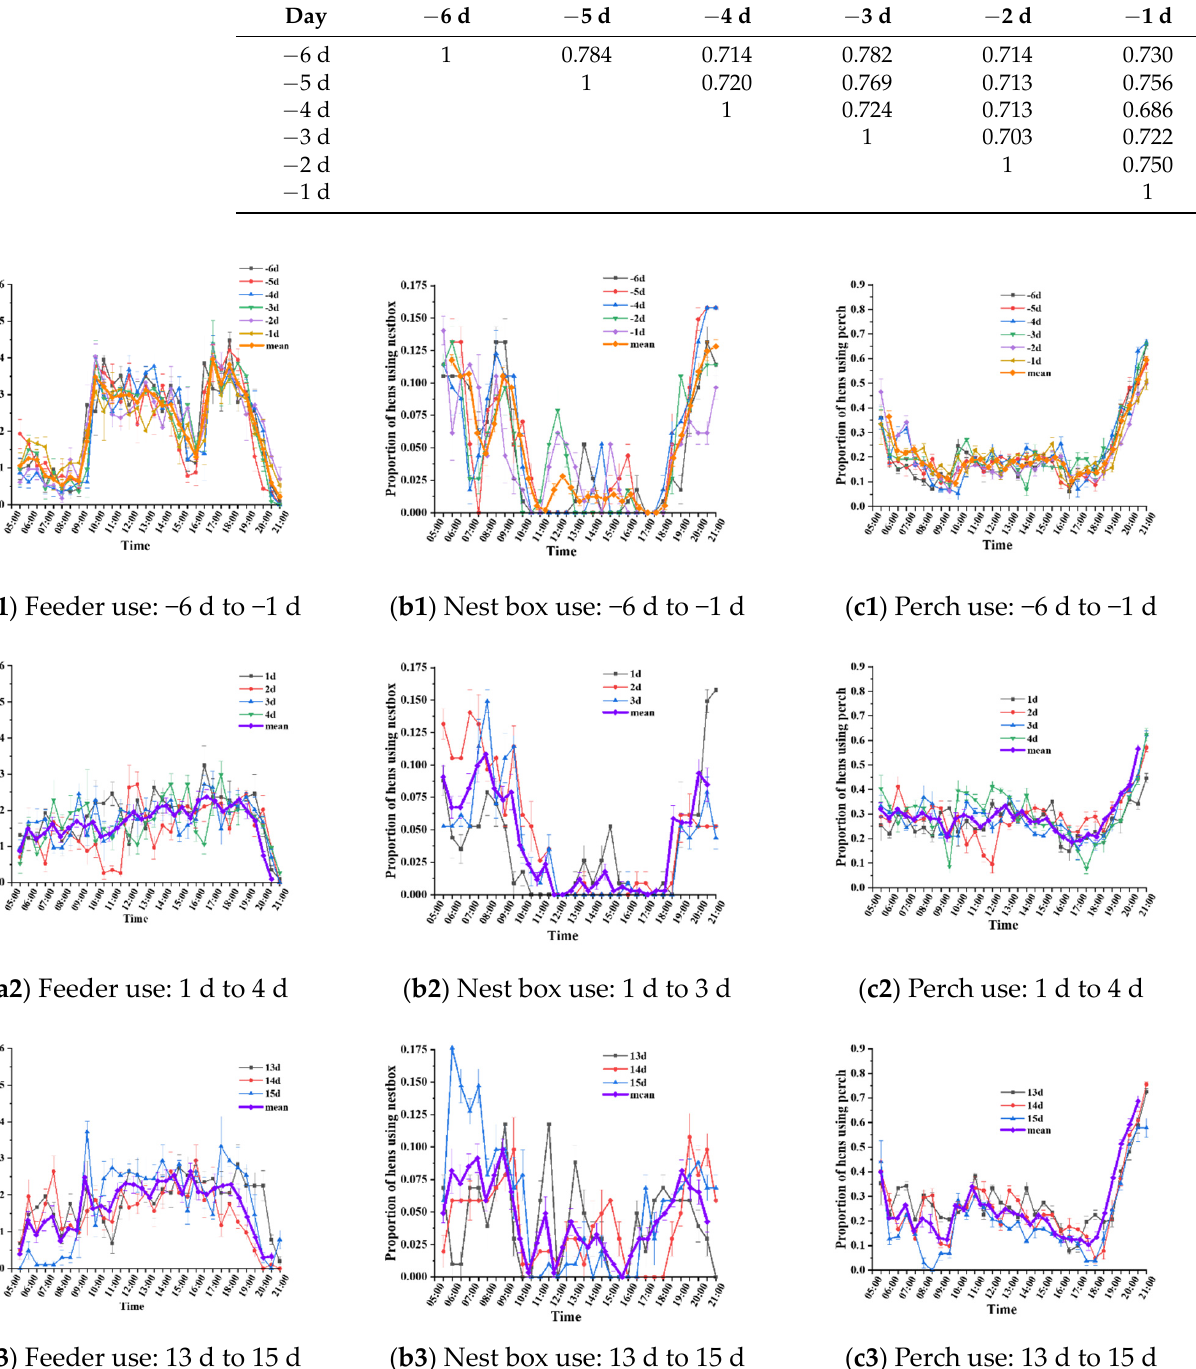
Figure 5. The diurnal pattern of hens using the feeder ( − 6 d to − 1 d ( a1 ), 1 d to 4 d ( a2 ), 13 d − 15 d ( a3 )), nest box ( − 6 d to − 1 d ( b1 ), 1 d to 3 d ( b2 ), 13 d − 15 d ( b3 )), and perch ( − 6 d to − 1 d ( c1 ), 1 d to 4 d ( c2 ), 13 d − 15 d ( c3 )). The average proportions of each measure of space use at − 6 d to − 1 d were depicted by thick orange lines (baseline), and plotted by thick violet lines at 1 d to 4 d and 10 d to 15 d. Table 2. The Euclidean Distance (ED) score for the diurnal pattern of hens using the feeder for each day from − 6 d to − 1 d.